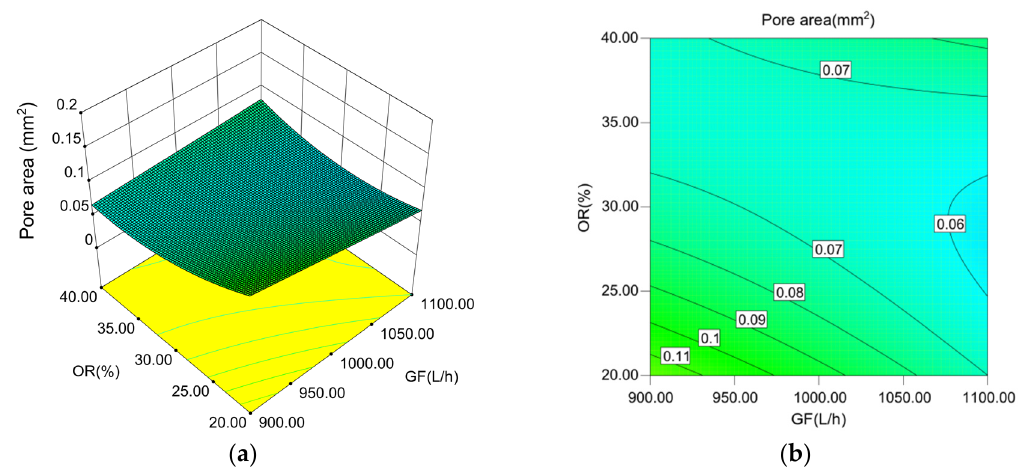
Figure 10. ( a ) Response surface of gas flow and overlap ratio interaction affecting the pore area; ( b ) Contour line of the response surface.